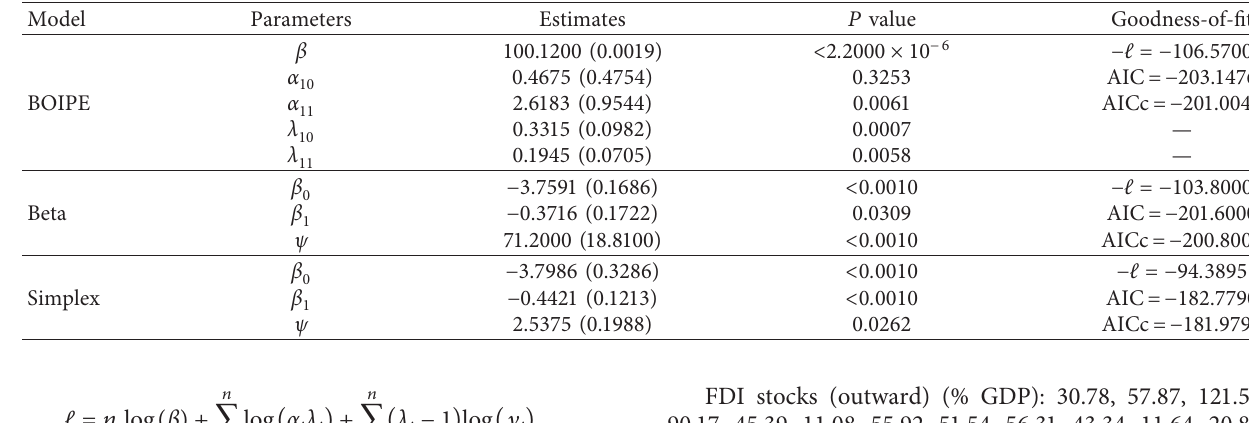
Figure 7: P-P plots of fitted distributions for data II: (a) BOIPE distribution. (b) B distribution. (c) K distribution. (d) BMOEE distribution. (e) ETL distribution. Table 8: Estimates of regression parameters and goodness-of-fit